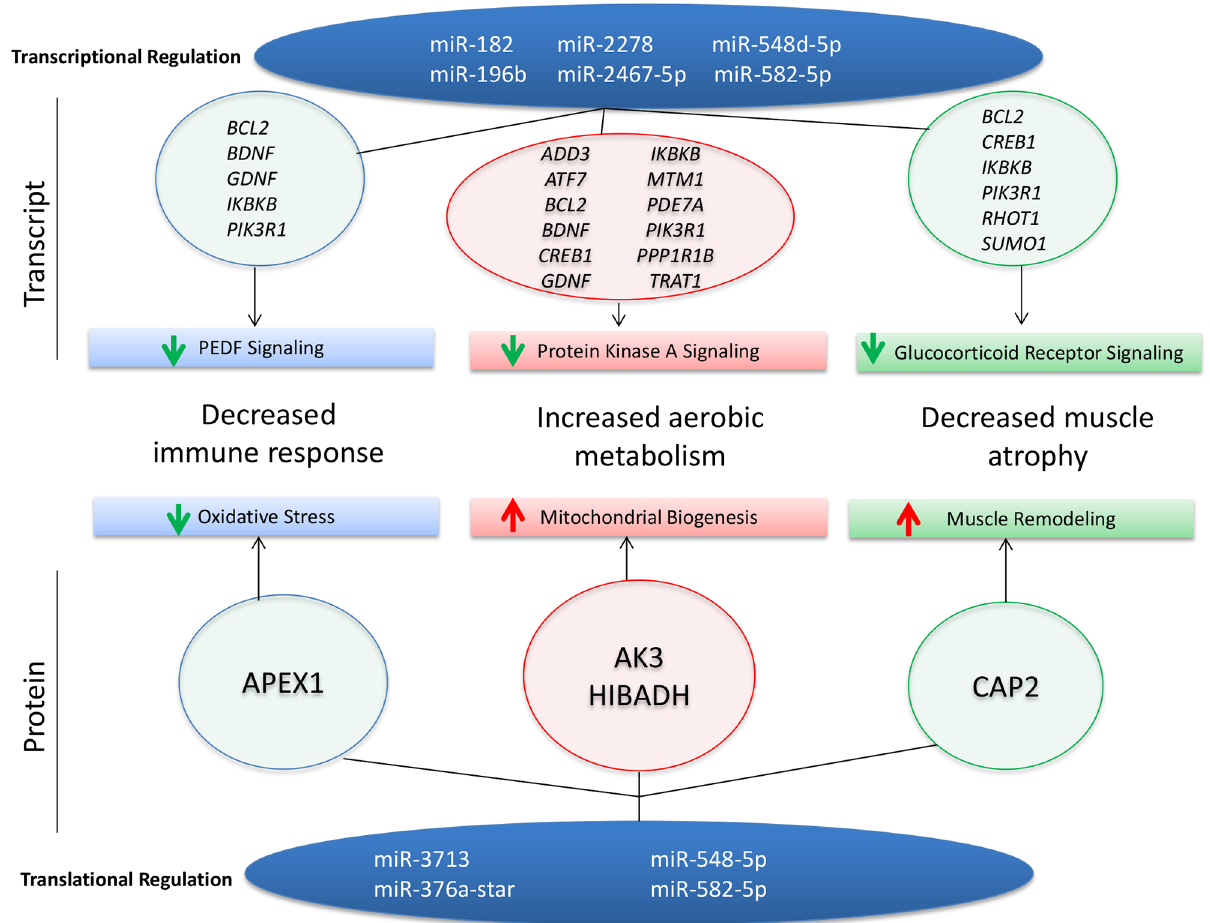
Fig 4. Exerciseinduces microRNAs that target transcripts and proteins important for muscle and immune response. Exercise- inducedmicroRNAs help improvediseaseoutcomes in myositis by modulating transcripts and proteinsimportant for aerobic metabolism, immune response,and muscle